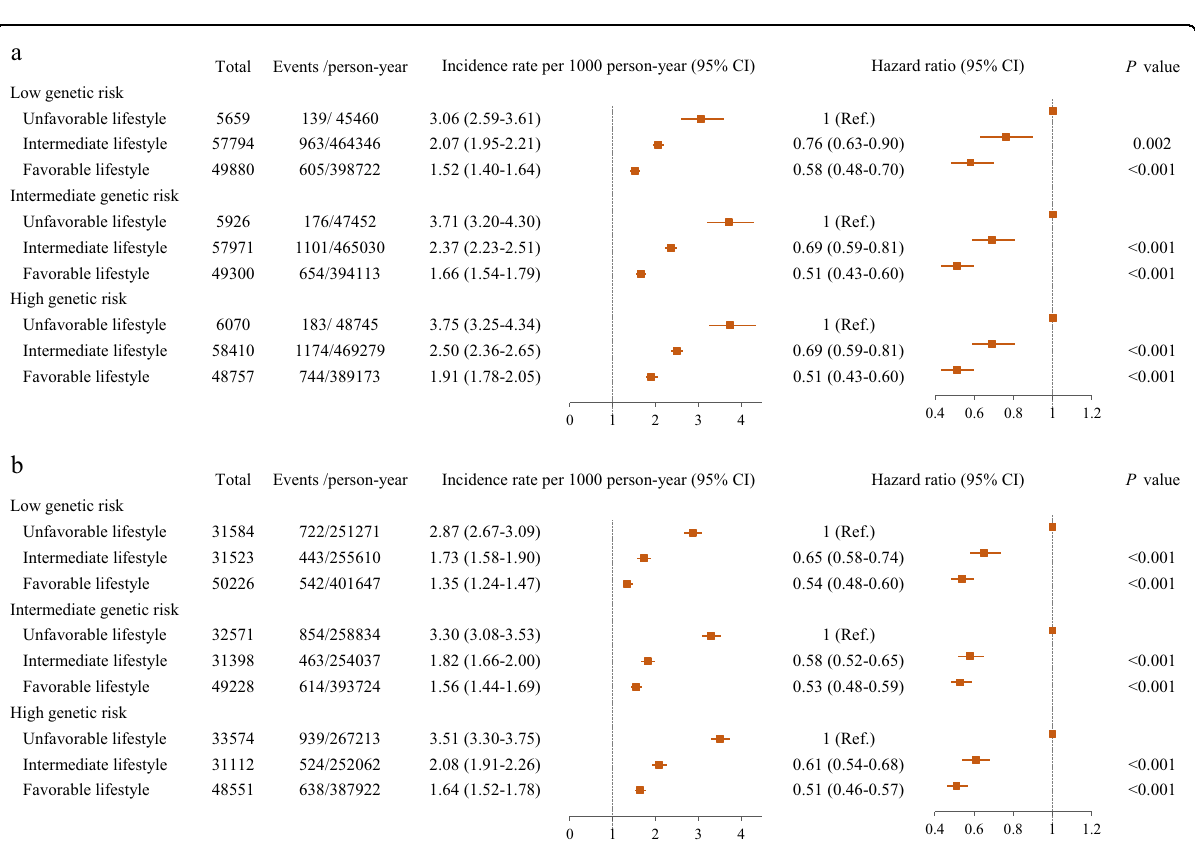
Fig. 2 The bene fi cial effect of healthy lifestyle factors on the risk of incident depression strati fi ed by genetic risk pro fi le. a Unweight lifestyle score and depression according to genetic risk; b weight lifestyle score and depression according to genetic